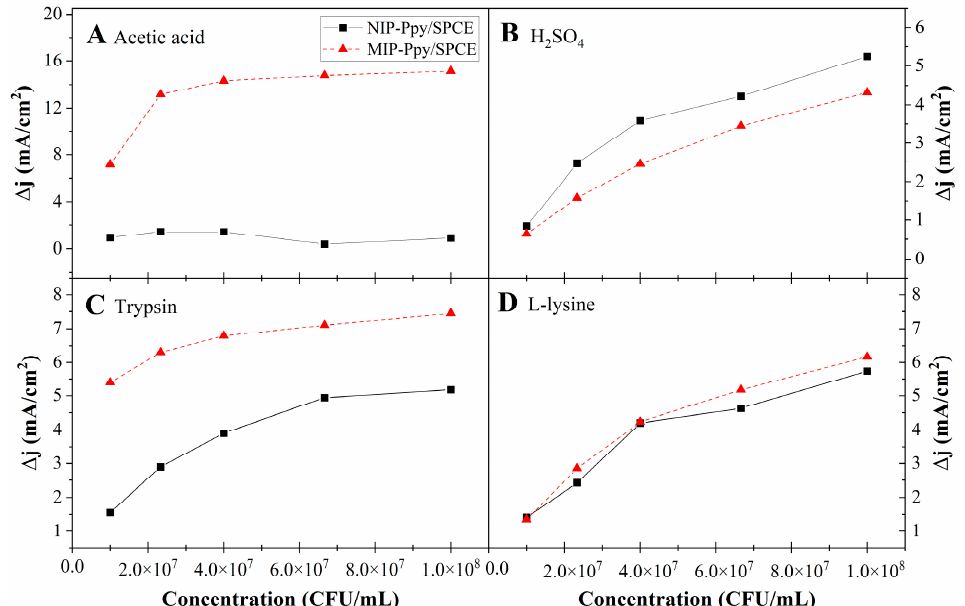
Figure 5. The current density of NIP-Ppy/SPCE (solid black lines) and MIP-Ppy/SPCE (dashed red lines) electrodes registered using pulsed amperometric detection after incubation in solutions containing different Listeria monocytogenes bacteria concentrations; Listeria monocytogenes from MIP- Ppy was extracted using different extraction solutions: ( A ) 10% acetic acid, ( B ) 0.05 M of sulphuric acid, ( C ) 10 U/mL of trypsin, ( D ) 0.1% L-lysine.